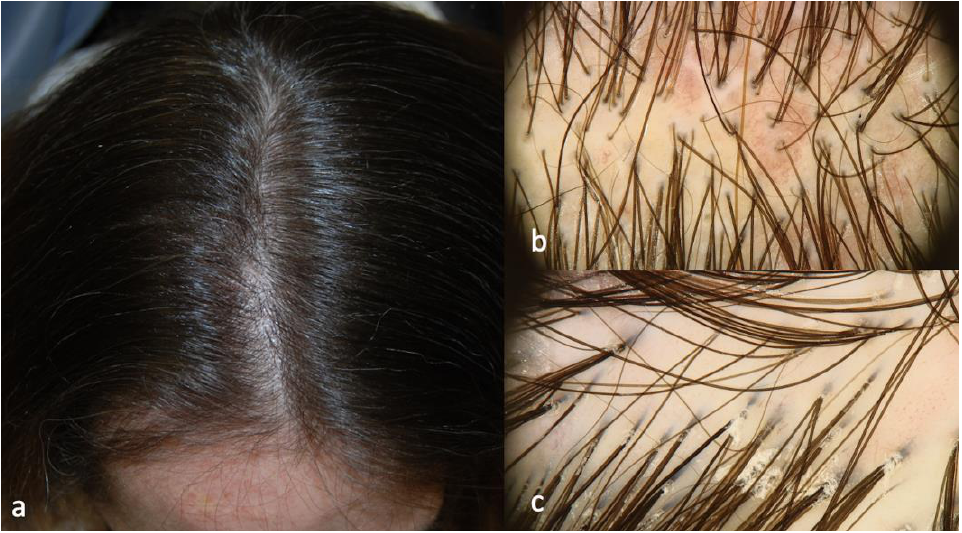
Figure 6. Clinical ( a ) and trichoscopic findings of Patient 4 and ( b , c ) magnification 20×.